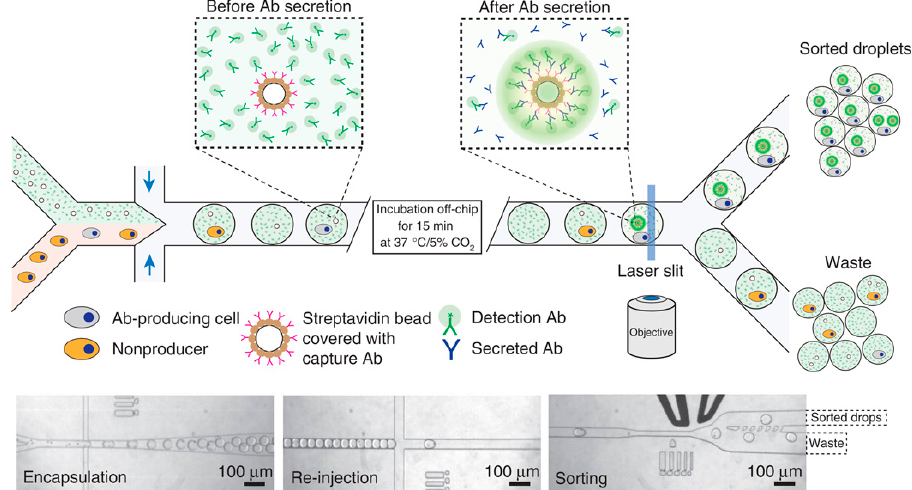
Figure 6. Integrated microfluidic system for single-cell screening, including key steps of cell encapsulation, incubation, fluorescence detection of metabolic molecules, and droplet sorting relying on the fluorescent intensities. Reproduction with permission from [91].